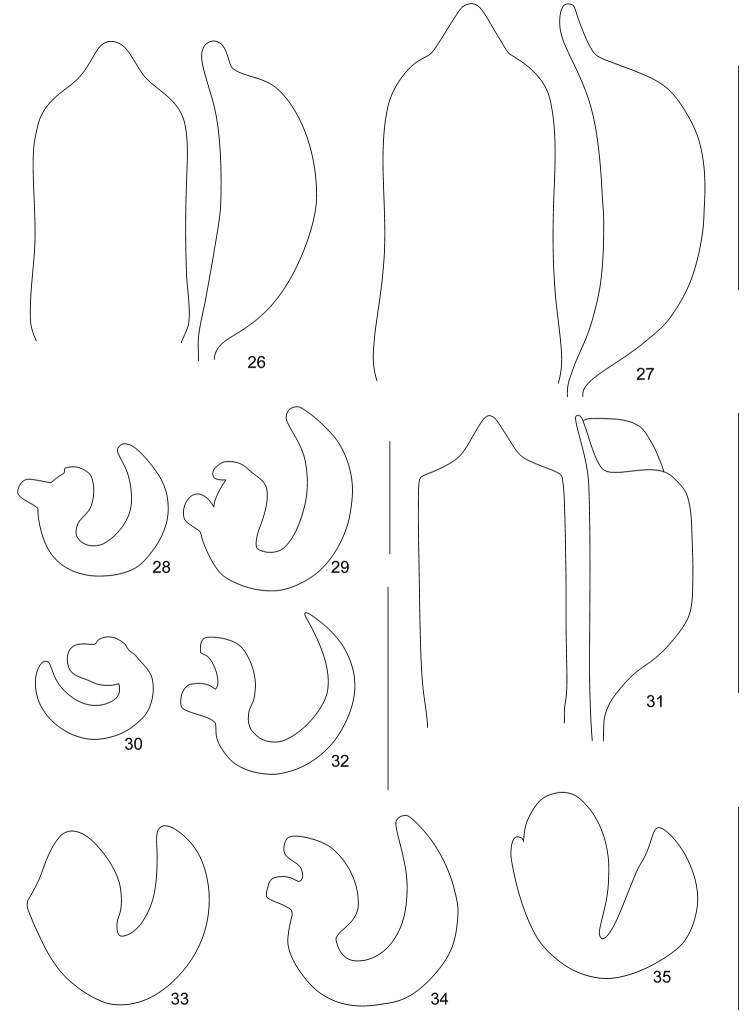
Genitalia of Rhinodontodes and Rhinodontus: 26 Penis of Rhinodontodes
alashanensis sp. nov., dorsal and lateral view 27 Penis of Rhinodontodes
subsignatus, dorsal and lateral view 28 Spermatheca of Rhinodontodes
alashanensis sp. nov. 29 Spermatheca of Rhinodontodes
subsignatus30 Spermatheca of Rhinodontus
crassiscapus31 Penis of Rhinodontus
ignarus, dorsal and lateral view 32 Spermatheca of Rhinodontus
ignarus33 Spermatheca of Rhinodontus
mongolicus34 Spermatheca of Rhinodontus
proximus35 Spermatheca of Rhinodontus
sawadai. Scale bars: 0.50 mm (26, 27, 31); 0.25 mm (28–30, 32–35).